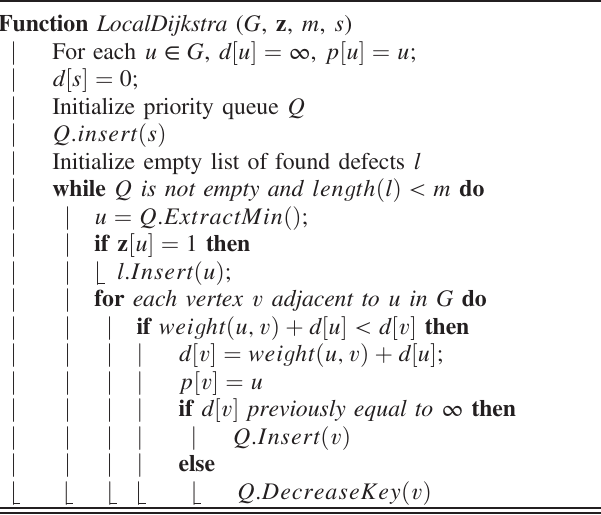
Algorithm 1. Local Dijkstra algorithm. Function LocalDijkstra ( G , z , m , s